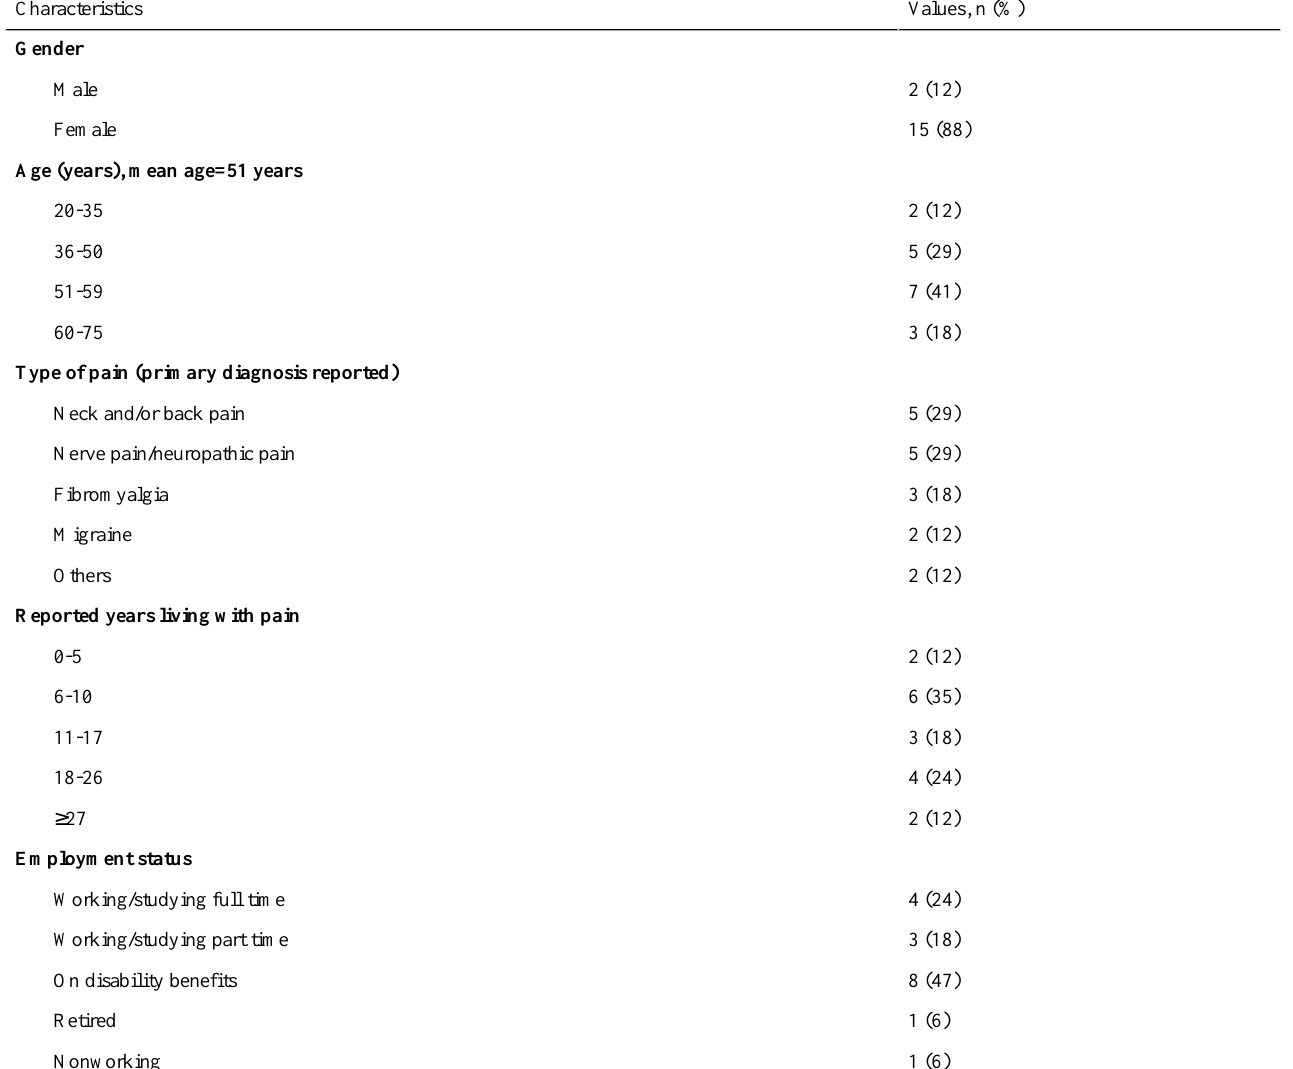
Table 3. Patient demographics